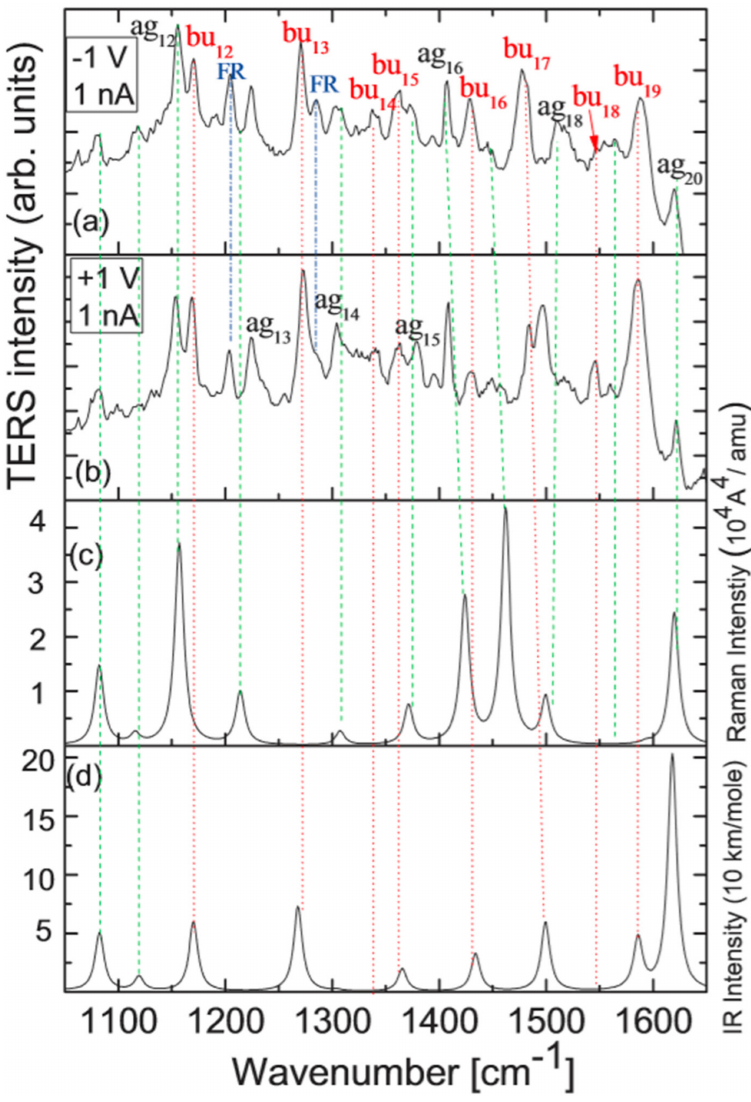
Figure 7. HV-TERS of DMAB that measured under 1 nA current and ( a ) − 1 V and ( b ) +1 V bias voltage, ( c ) calculated Raman and ( d ) IR spectra of DMAB